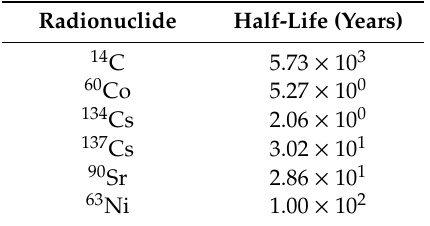
Table 3. List of concerned potential radionuclides.